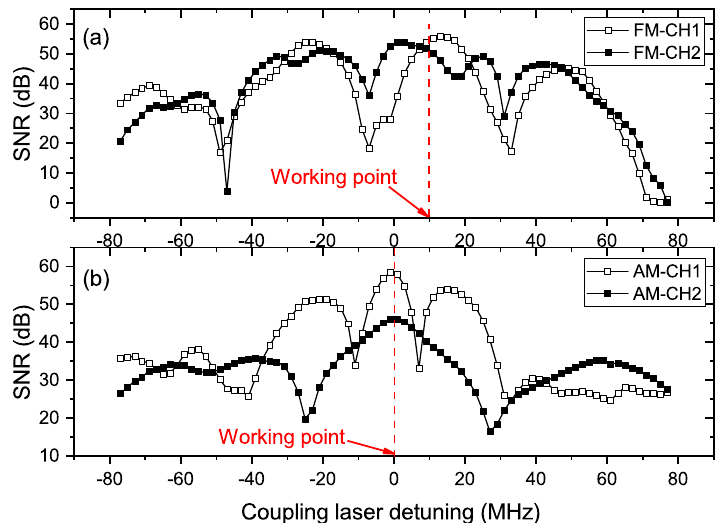
Figure 3. Observed signal-to-noise ratio (SNR) and working points of coupling laser. Results for dual-channel AM and FM communication are shown in ( a ) and ( b ),